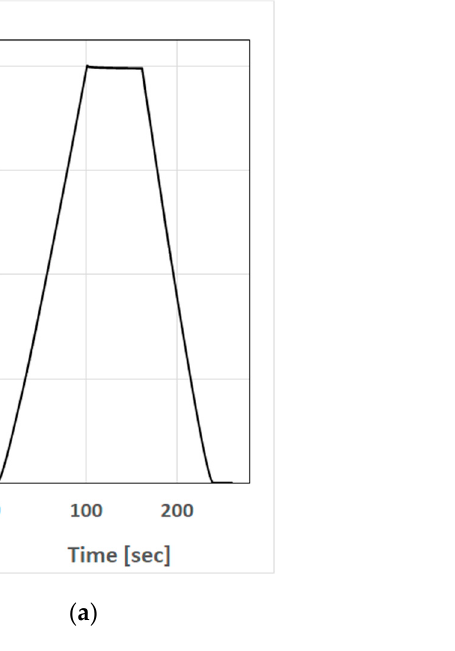
Figure 4. Indentation test: ( a ) indentation load vs. time; ( b ) projected intended area.